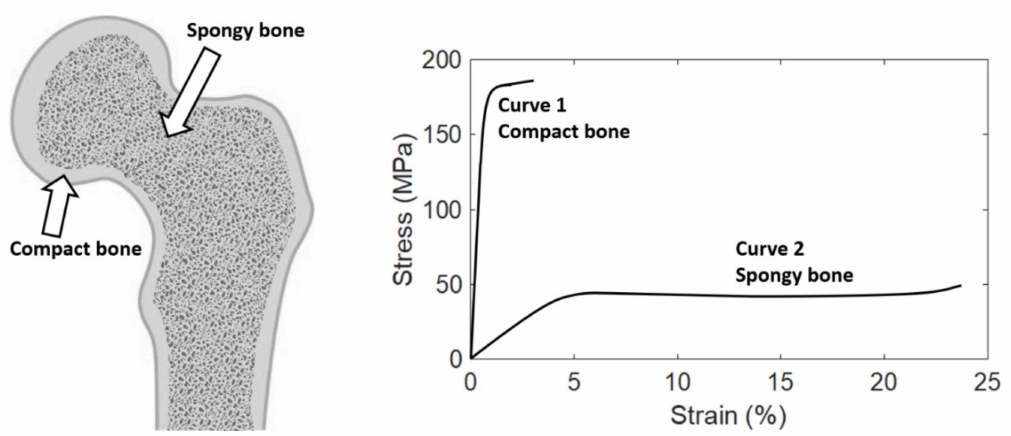
Figure 1. Left : Bone tissue can be categorized as two types, compact bone and spongy bone. Right : The typical stress–strain curves of compact and spongy bones. The last point of the stress–strain curve is the failure point. This figure is adapted from